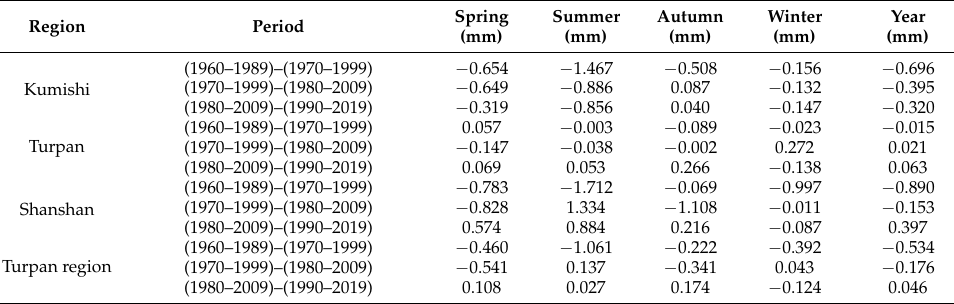
Table 3. Changes in precipitation normal value in the Turpan